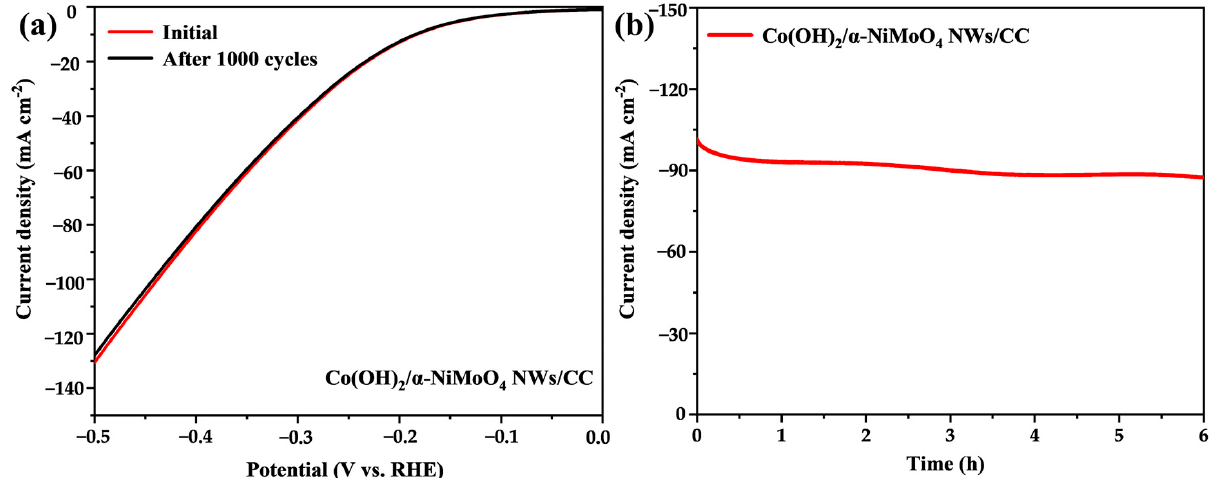
Figure 5. ( a ) LSV curves of Co(OH) 2 / α -NiMoO 4 NWs/CC electrocatalysts after 1000 cycles of CV; ( b ) stability of Co(OH) 2 / α -NiMoO 4 NWs/CC electrocatalysts at − 0.40 V vs. RHE.